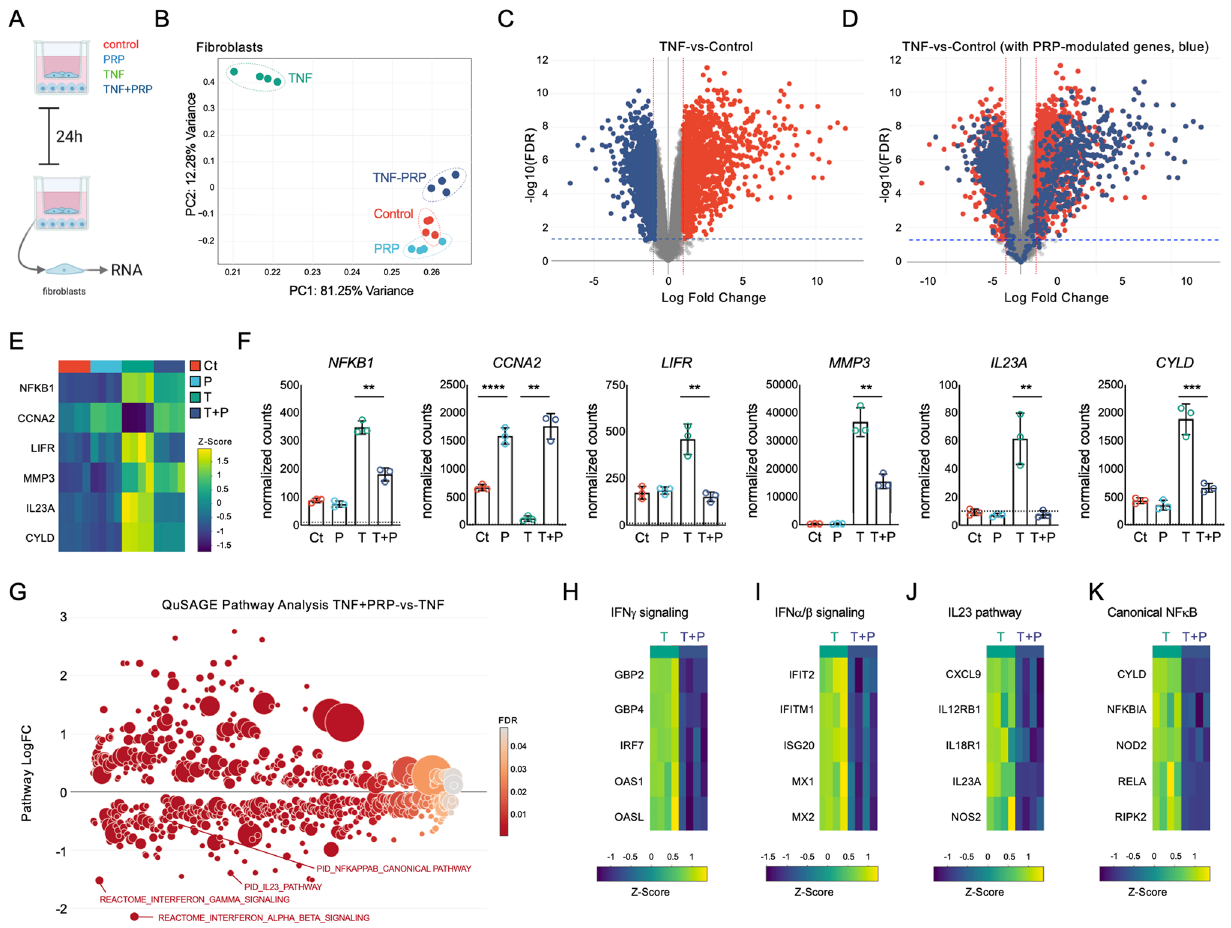
Figure 3. Transcriptomic analyses of the modulation of TNFα-driven responses by PRP in fibroblasts. ( A ) Schematic representation of the experimental workflow. Created with BioRender.com ( B ) Principal component analysis (PCA, using top 1,000 genes) of RNA-seq data from fibroblasts left untreated, or treated with TNFα and PRP, alone or combined, for 24 h. RNA-seq analysis is based on 4 independent coculture experiments, with fibroblasts isolated from 4 different tissue donors and PRP prepared from 4 different subjects. ( C ) Volcano plot of differentially expressed genes comparing TNFα-treated fibroblasts to untreated controls. Colored dots correspond to genes with significant changes greater than 1 log2-fold expression change (FDR < 0.05, LogFC > 1). Red indicates increased expression and blue indicates decreased expression after TNFα treatment. ( D ) Volcano plot representing PRP-induced changes in fibroblasts co-treated with TNFα + PRP. Red dots represent differentially expressed genes (DEGs) induced by TNFα relative to untreated controls, and blue dots represent PRP-induced changes in PRP + TNFα treated cells relative to TNF-treated cells (FDR < 0.05, LogFC > 1). ( E ) Heatmap representation of selected DEGs by RNA-seq, and ( F ) NanoString analyses showing the normalized counts of these same selected genes, confirming changes in the control (Ct), PRP- (P), TNFα- (T) and PRP + TNFα-treated (P + T) fibroblasts. Dotted lines indicate background signal. ** p < 0.01, *** p < 0.001, **** p < 0.0001 by t -test, calculated using ratio data and the nSolver analysis software. NanoString data is represented as the mean ± S.D (error bars) normalized counts of 3 independent coculture experiments, using fibroblasts isolated from 3 different tissue donors and PRP prepared from 3 different subjects. Graphs were created with GraphPad Prism 8. ( G ) Representation of the QuSAGE pathway analyses in TNFα + PRP-treated fibroblasts relative to TNFα-treated cells, showing functional pathways differentially expressed in TNFα + PRP- treated cells (FDR < 0.05). Heatmap representation of representative genes associated with the ( H ) interferon gamma, ( I ) interferon alpha beta, ( J ) IL23, and ( K ) canonical NF-κB signaling pathways. Data was z-score tional profiles, with robust and pronounced differences in TNFα-treated fibroblasts vs. non-treated controls, and remarkable differences between TNFα + PRP and TNFα-treated cells (Fig. 3B). Comparison of fibroblasts treated with PRP relative to non-treated controls uncovered 776 differentially expressed genes, including IGF1 , VEGFA , CDK1 , IL1A , and other genes involved in replication, proliferation, DNA repair, and cell survival. Compari- son of TNFα-treated fibroblasts with control cells (Fig. 3C) showed a robust induction of classic inflammatory and NF-κB-responsive genes (including CCL5 , NFKBIA , or RELA ) as well as up-regulation of IFN signature genes (including MX1 , MX2 , IRF1 , IRF7 or SOCS ). Fibroblasts co-treated with PRP and TNFα showed very